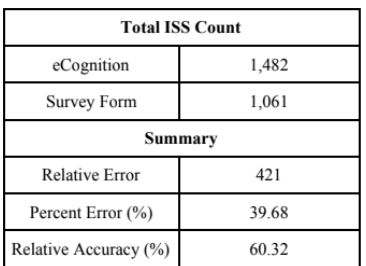
Table 8. Summary of the ISS count through eCognition and through crowdsourcing.